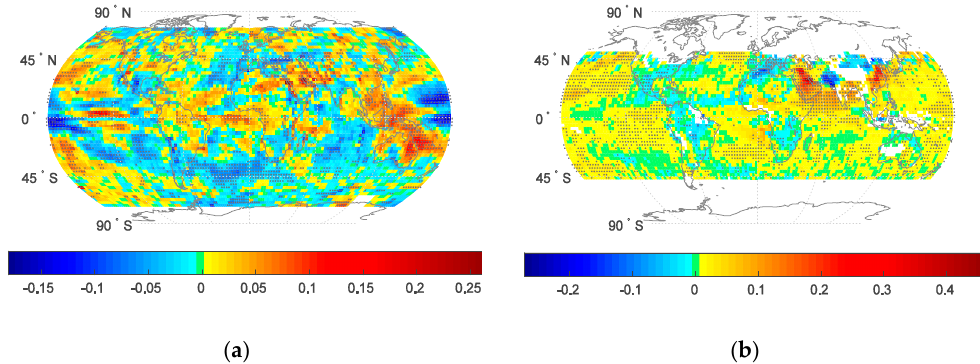
Figure 4. Tendencies of total cloud cover ( a ) and aerosol optical thickness ( b ) over the period 2001–2009. Total cloud cover (TCC) values are expressed in percentages (%) when multiplied by 100 and aerosol optical thickness (AOT) values are unitless. Dots indicate geographical cells for which the TCC and AOT tendencies are statistically significant.